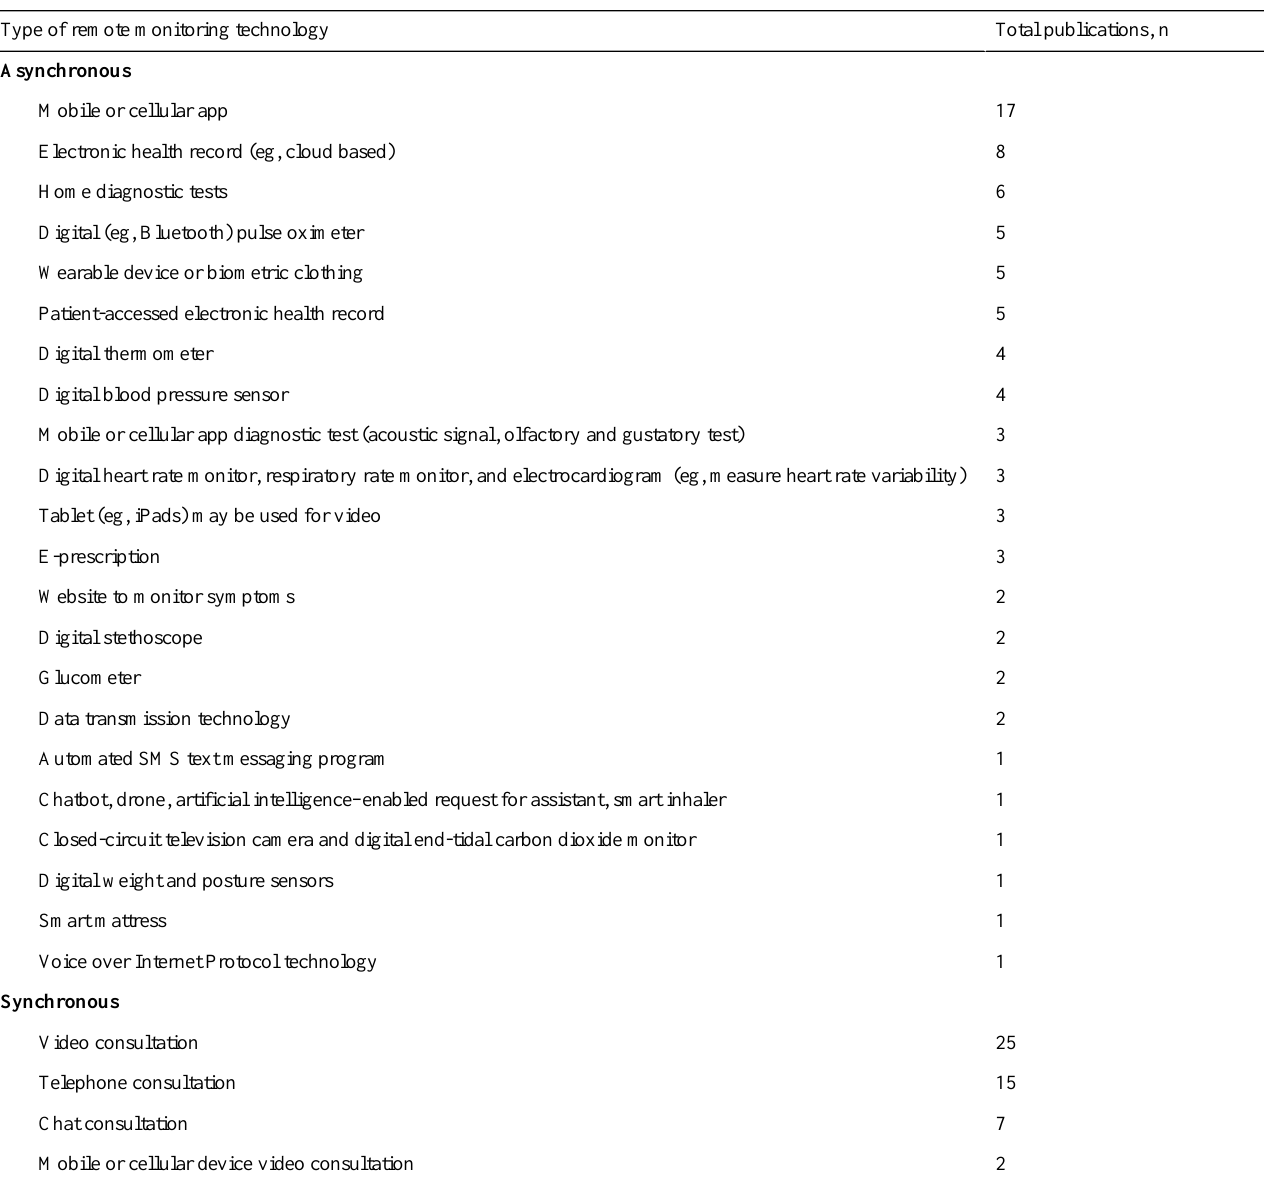
Table 2. Summary of remote monitoring technologies grouped into synchronous or asynchronous.